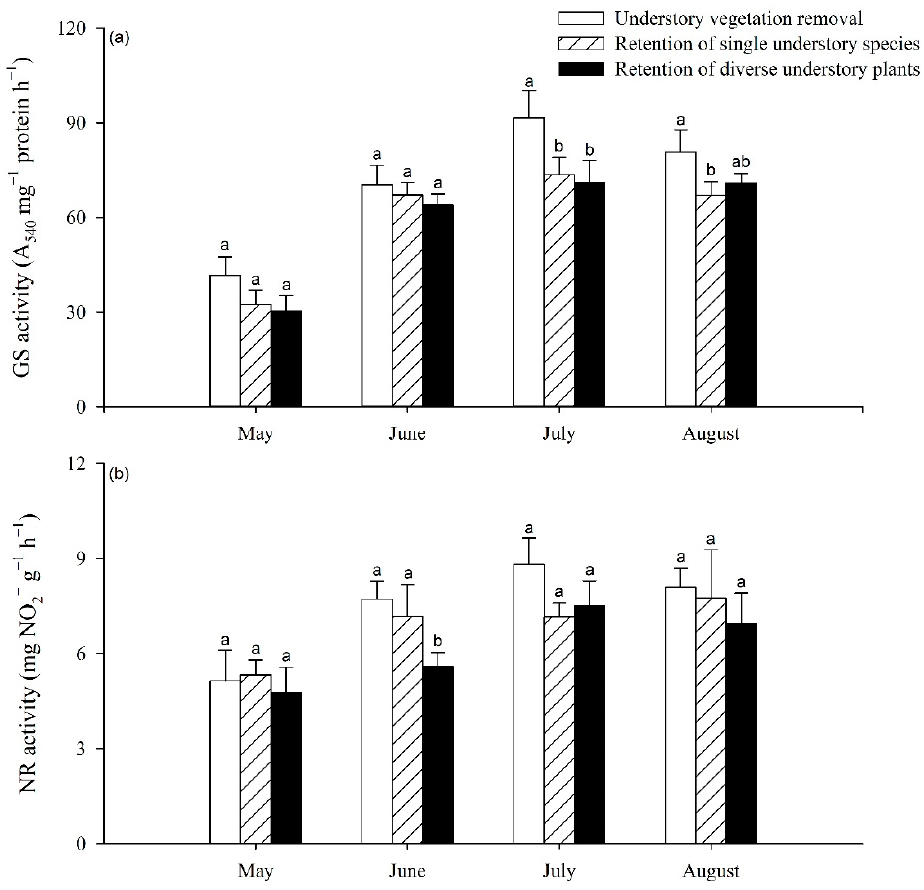
Figure 3. Variation in poplar foliar GS ( a ) and NR ( b ) activity with increase in understory vegetation species richness. Different letters indicate significant differences between treatments at p < 0.05.